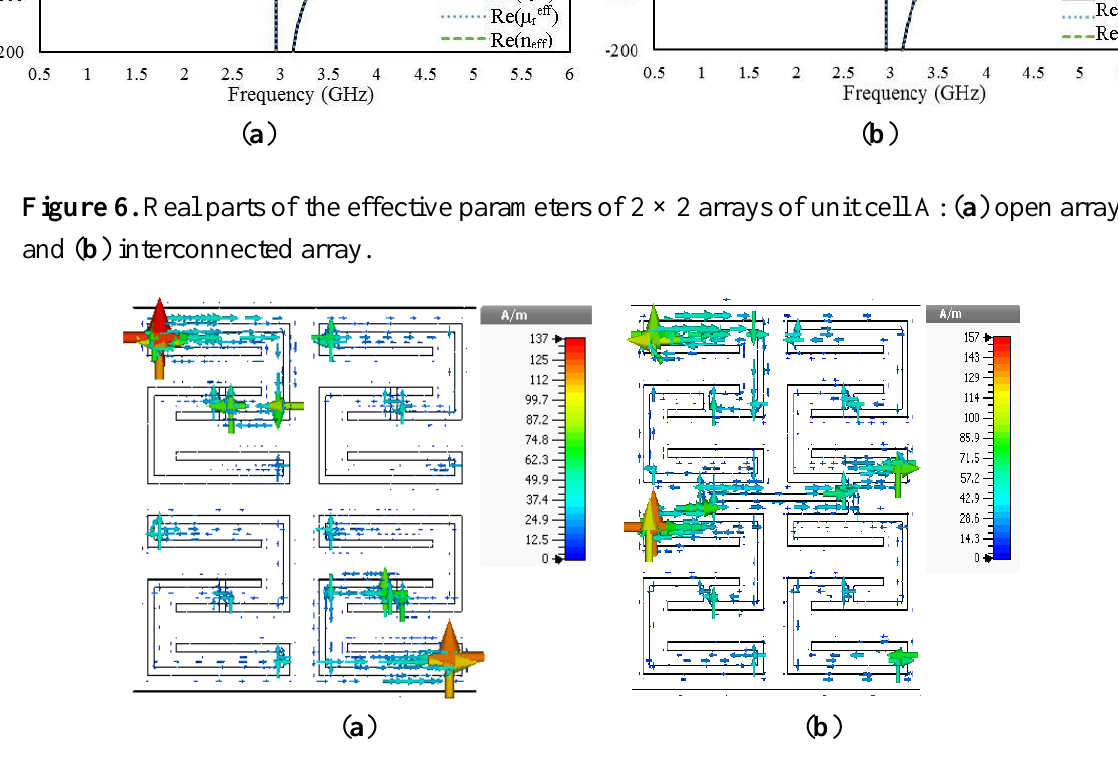
Figure 7. Surface current distributions of 2 × 2 arrays of unit cell A at 3.5 GHz: ( a ) open array and ( b ) interconnected